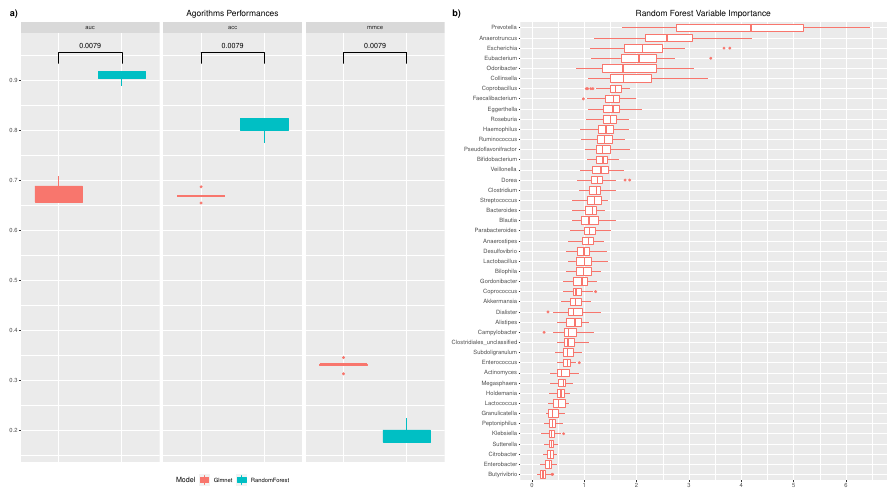
Figure 1. ( a ) Comparison of the 5 times 10-fold CV using a Wilcoxon test and ( b ) RF variable